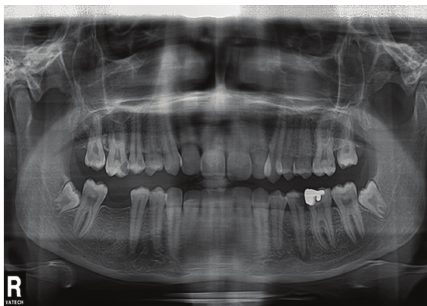
Figure 2: Preoperative panoramic radiograph of the case. Root of mandibular left second premolar seems to be in close proximity to mental nerve.